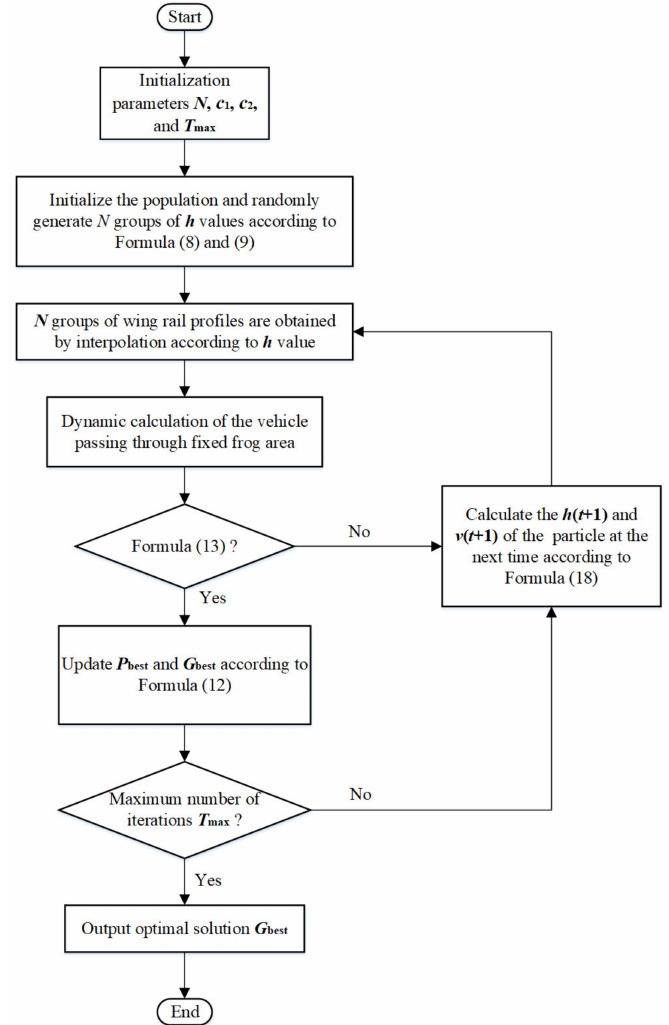
Figure 8. Flow chart of the wing rail optimization algorithm based on the PSO.